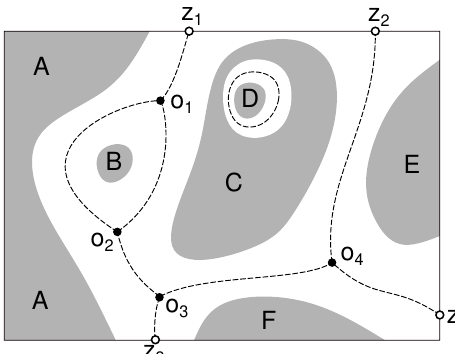
Figure 2. An example of continuous regions A, B, C, D, E, F, and their expanding boundaries (dashed lines), region corner o i ( i = 1,2,3,4) (solid circles), and border corner z i ( i = 1,2,3,4) (open